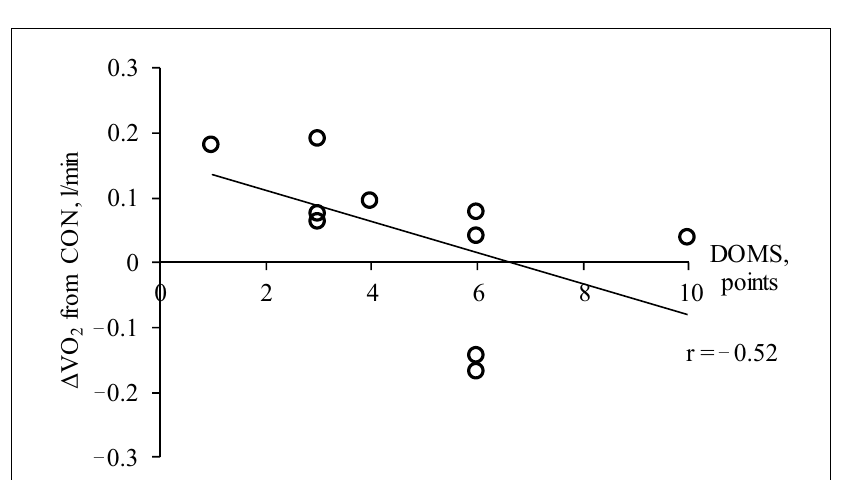
Figure 3. The correlation between changes (from control moderate cycling conditions (CON)) on oxygen uptake (ΔVO ) during moderate cycling 45 minutes after prior drop 2 jumps and delayed onset muscle soreness (DOMS) 24 hours after prior drop jumps